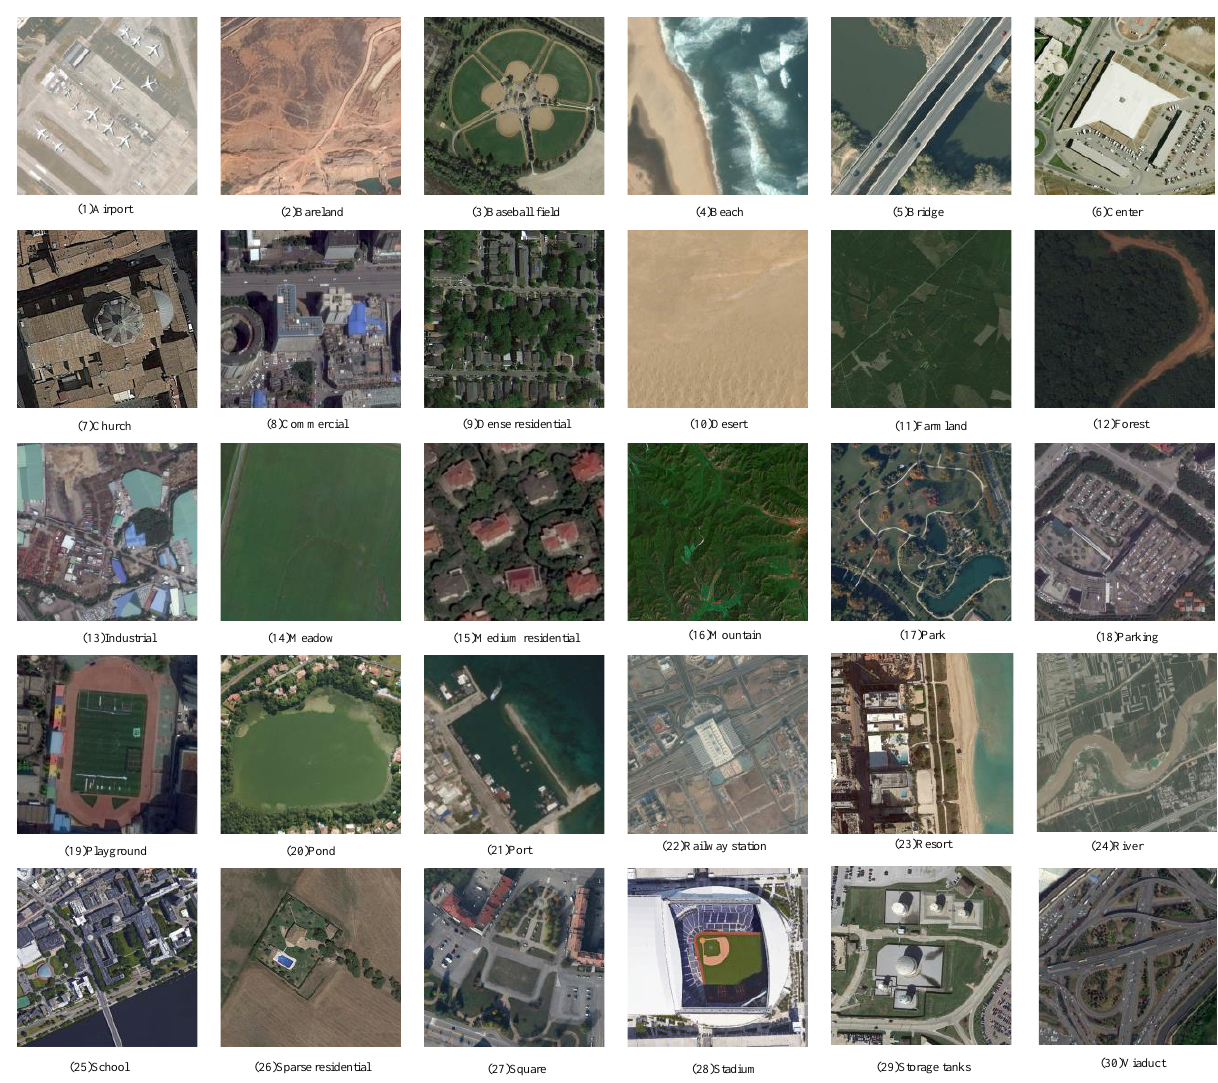
Figure 4. Some samples from the AID30 dataset.